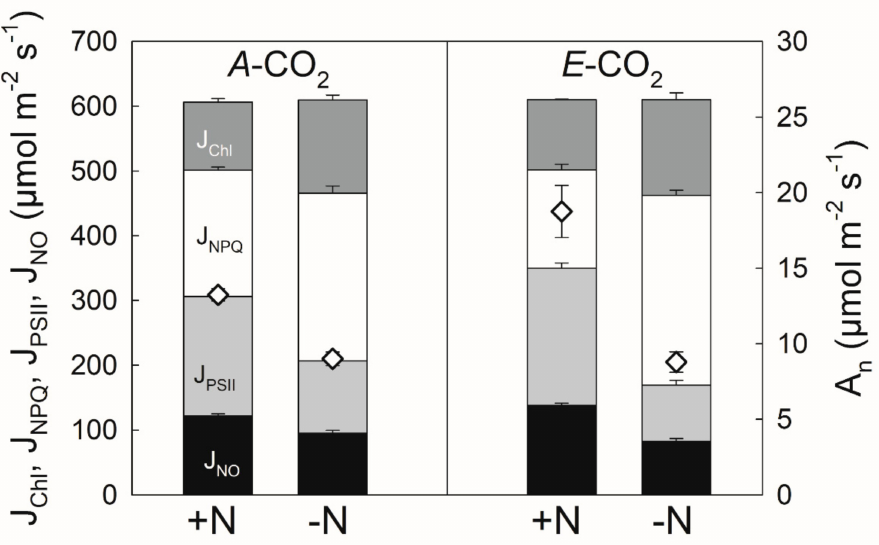
Figure 1. Fate of light energy partitioning in the seedlings of Japanese white birch grown with N limitation under elevated CO 2 . J Chl , J NPQ , J PSII and J NO were measured in the seedlings of Japanese white birch grown under ambient ( A -CO 2 ) and elevated CO 2 ( E -CO 2 ) with adequate ( + N) and limited N supply (-N). Open diamonds indicate net photosynthetic rate (A n ). Measurements were conducted for fully-developed mature leaves (leaf age was approx. 1 month) under respective growth CO 2 concentrations (i.e., 360 µ mol mol − 1 for ambient-CO 2 -grown plants, and 720 µ mol mol − 1 for elevated-CO 2 -grown plants) at saturating light (1200 µ mol m − 2 s − 1 ). Values are means ± se ( n = 4–6). Data were obtained from Kitao et al. [32]. J Chl , J NPQ and J NO were newly calculated based on data from the previous